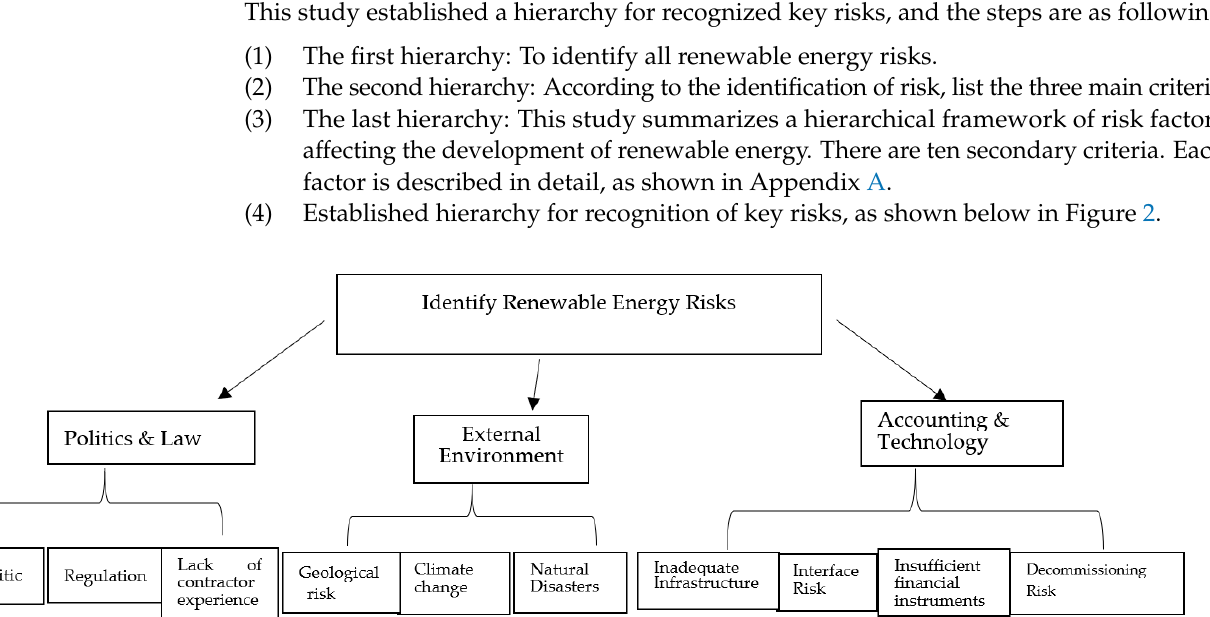
Figure 2. Established hierarchy for recognition of key